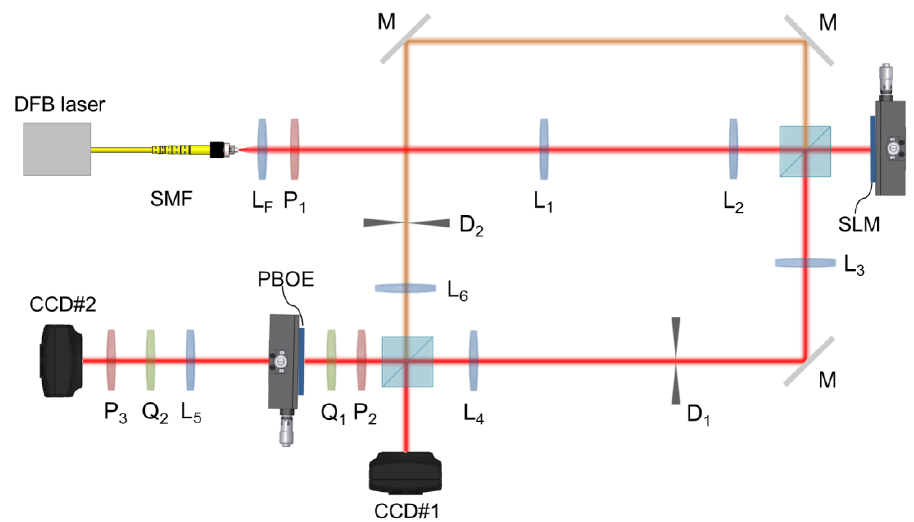
Figure 5. Scheme of the experimental setup used for the optical characterization of the fabricated sorter. The DFB laser output ( λ = 1310 nm) is collimated at the end of the single mode fiber by means of an aspheric lens with a focal length f F = 7.5 mm, is linearly polarized (P 1 ) and is expanded ( f 1 = 3.5 cm, f 2 = 10.0 cm). The SLM first order is filtered (D 1 ) and resized ( f 3 = 20.0 cm, f 4 = 12.5 cm) before illuminating the sorter. A beam splitter (BS) is used both to check the input beam and collect the sorter output at the back focal plane of a fifth Fourier lens ( f 5 = 7.5 cm). A sequence of linear polarizers and quarter-wave plates is placed before (P 2 , Q 1 ) and after (Q 2 , P 3 ) in the optical element, in reverse order, in order to generate and filter the desired circular polarization states. A Mach-Zehnder interferometric setup is added in order to analyze the singularity order of the generated OAM beams.